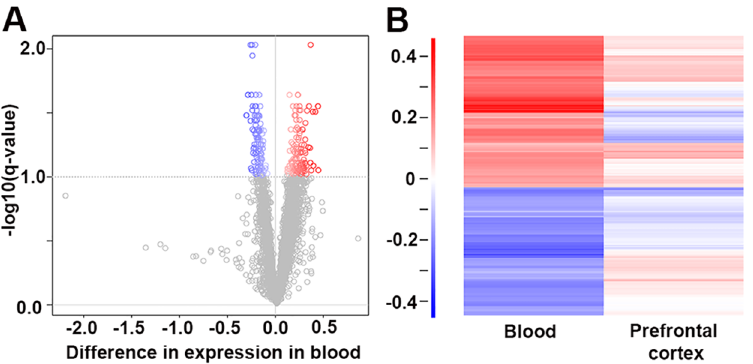
Fig 4. Differential gene expressionin animals stratified for behavioral treatment response to chronic paroxetine treatment. (A) Volcanoplot showingresults from blood samples. The biological effect size (difference in expression) is plotted againststatistical significance(as negativelog 10 transformed values of the FDR-based q -value).Regarded as significantly regulated,259 probes with q -values < 0.1 are colored accordingto their difference in expression. (B) Heat map comparingpatterns of differentialgene expression in blood and prefrontal cortex. Each row in the plot represents the difference in expressionof 1 microarrayprobe betweenpoor and good responders in both blood and prefrontalcortex. The array probes are ordered accordingto agglomerative hierarchicalclustering, but no large common gene regulationpatterns are revealed between the 2 tissues. Scale for color codingdifference in expressionis identicalfor (A) and (B). All raw data for Fig 4 are availablein S1 Data. FDR, false discovery rate.